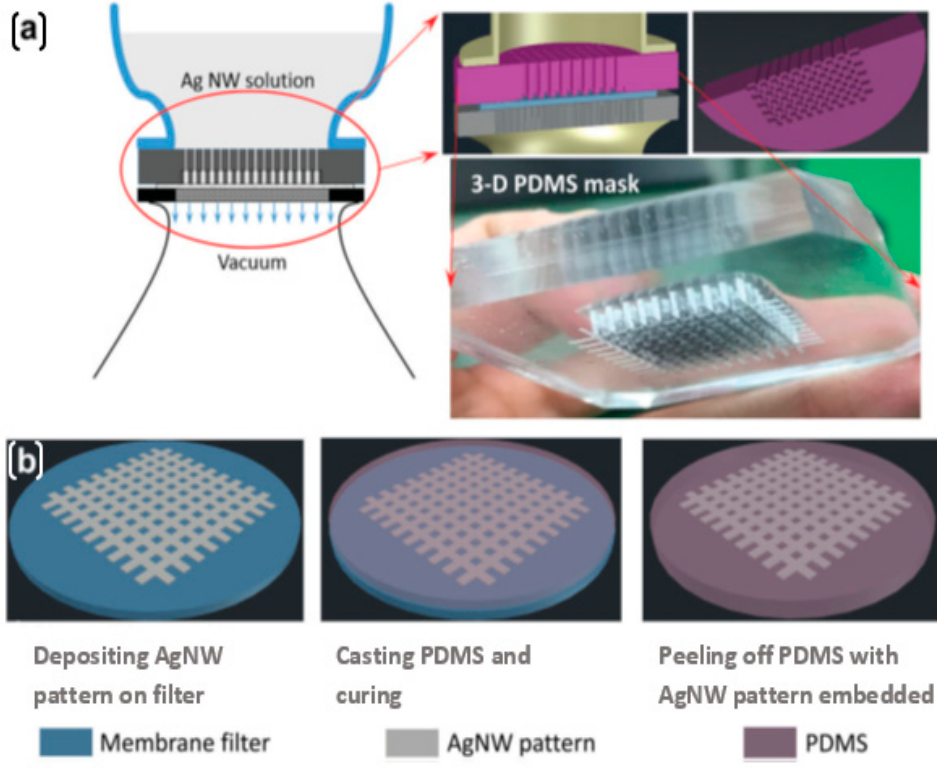
Figure 5. Steps in fabricating AgNW patterns on a membrane filter using 3D mask ( a ) Vacuum filtration the process ( b ) Depositing AgNW pattern, transferring to target PDMS substrate, and peeling off PDMS. Reprinted with permission from Ref. [68]. Copyright 2018, Royal Society of Chemistry. An ordered AgNW array on PDMS substrate achieves higher sensitivity and trans- parency. Strain sensors fabricated using an ordered AgNW array/PDMS composite and a simple water-bath pulling method displayed a GF of 84.6 and a transparency of 86.3% [69]. AgNW ohmic contacts are formed when the PDMS surface is pulled out of the solution in two orthogonal directions, as shown in Figure